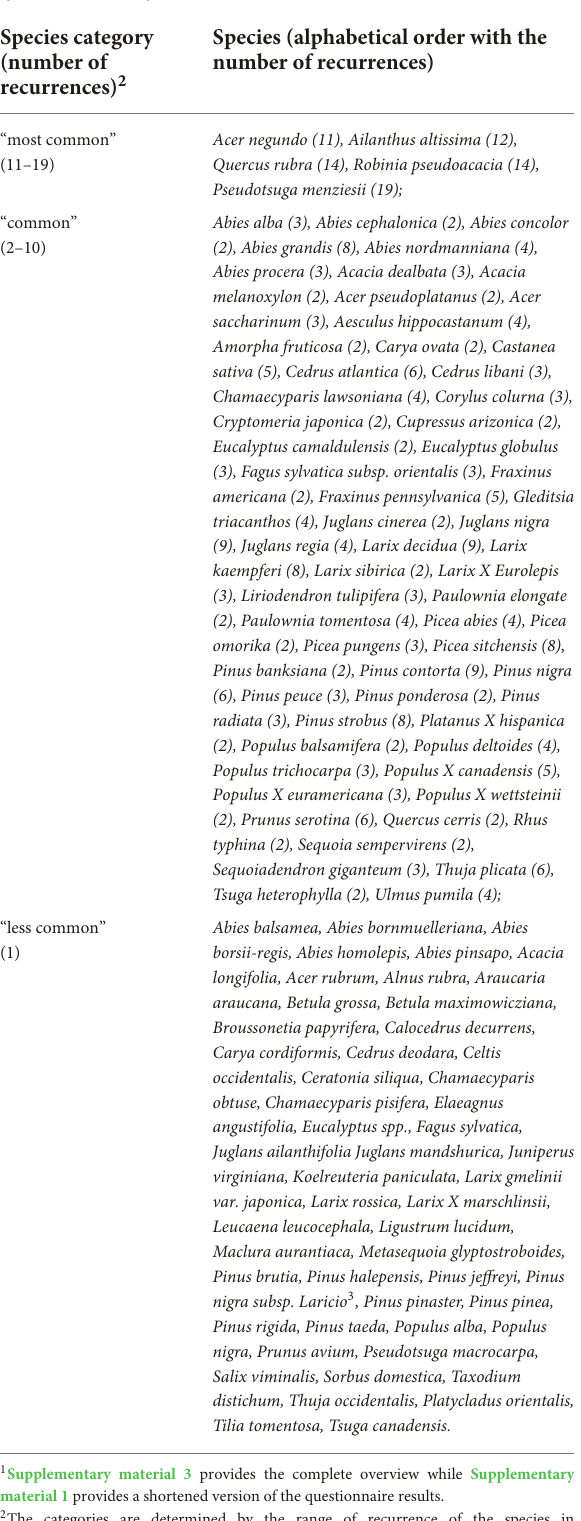
TABLE 1 Species categorization based on recurrences in the questionnaire output. 1 Species category (number of recurrences)